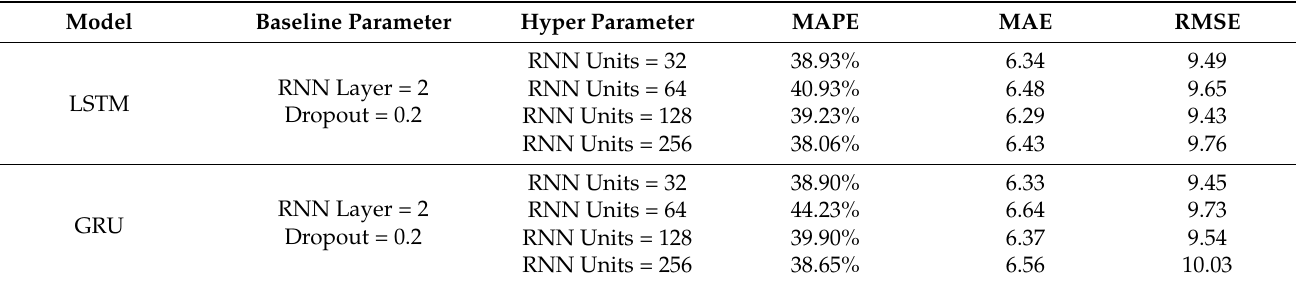
Table 2. Selection of hyperparameters on LSTM and GRU.